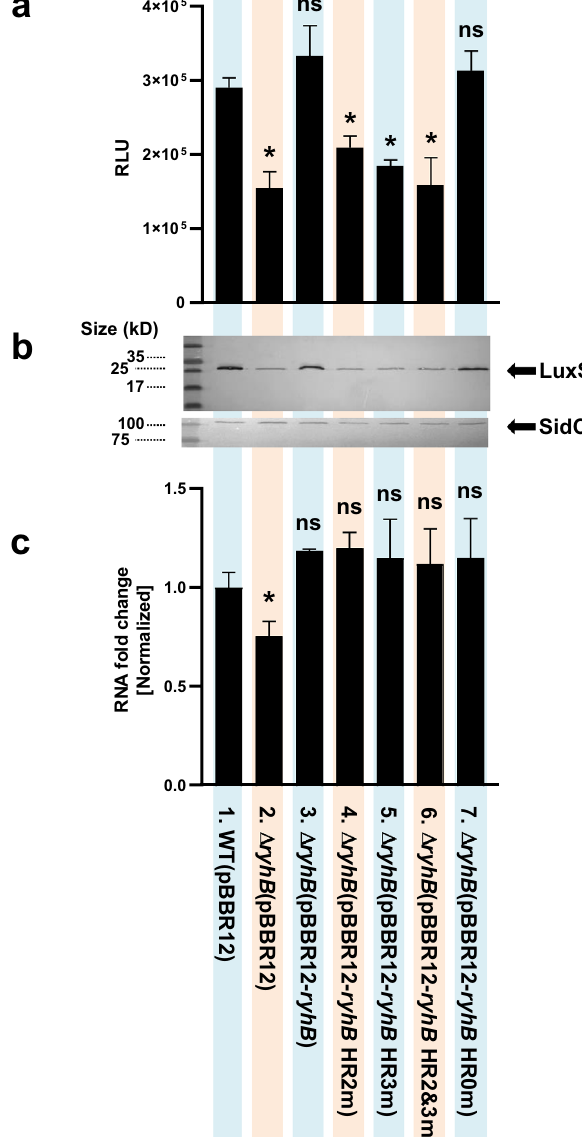
Figure 10. Effects of the hybridization between RhyB and luxS mRNA on expression of LuxS. ( a ) Influence of hybridization regions HR2 and HR3 on the production of AI-2 by LuxS as measured using the V. harveyi indicator strain BB170. The following V. vulnificus strains were cultured in AB minimal medium and sampled for the presence of AI-2 in the supernatant: 1, wild type (MO6 pBBR12); 2, ryhB deletion mutant (Δ ryhB pBBR12); 3, Δ ryhB with a wild type ryhB clone (Δ ryhB pBBR12- ryhB ); 4, Δ ryhB with a mutated region HR2 clone (Δ ryhB pBBR12- ryhB HR2m); 5, Δ ryhB with mutated region HR3 clone (Δ ryhB pBBR12- ryhB HR3m); 6, Δ ryhB carrying a clone with both HR2 and HR3 mutated (Δ ryhB pBBR12- ryhB HR2&3m); 7, Δ ryhB with a clone carrying an unrelated mutated region as a control (Δ ryhB pBBR12- ryhB HR0m). The presence of AI-2 was measured in RLU, relative light units (luminescence/A 600 ). Values are averages from three independent experiments and error bars denote the standard deviations. The p -values as compared with MO6-24/O pBBR12 are indicated (Student’s t -test; *, 0.005 ≤ P < 0.05; ns, no significant). ( b ) Effects of HR2 and HR3 on the production of LuxS as measured by western hybridization. Western blot analysis of LuxS levels in whole cell lysates was measured. As a control, insulinase enzyme (SidC) (Kim et al., 2015. J. Biol. Chem. 290:18708), which is not regulated by quorum-sensing, was included. ( c ) The relative mRNA levels of luxS were measured using qRT-PCR for each of the strains listed in 10A. Cells were cultured in AB broth for 5 h until they reached an A 600 of 0.3, at which point samples were collected for RNA purification and qRT-PCR analysis. The p -values for comparison with MO6-24/O pBBR12 are indicated (Student’s t -test; *, 0.005 ≤ P < 0.05; ns, no